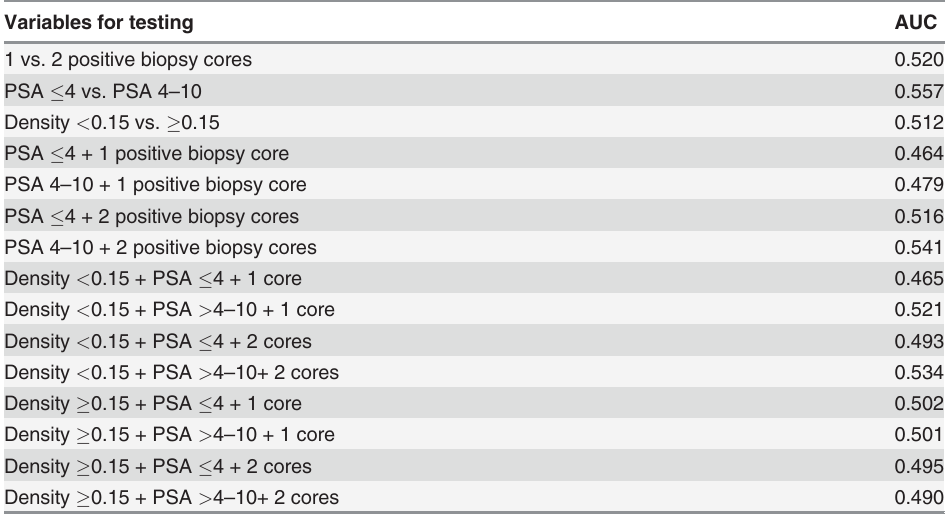
Table 6. Logistic regression for predicting PCa